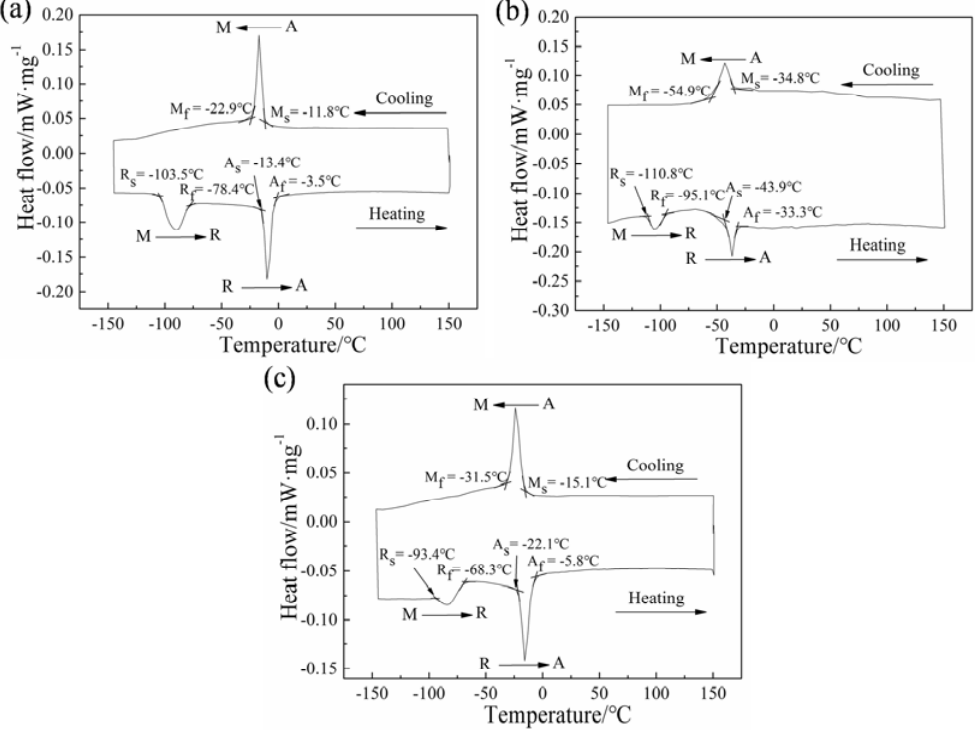
Figure 7. DSC (Differential scanning calorimetry) curves of the three NiTi-based SMAs: ( a ) Ni 45 Ti 51.8 Fe 3.2 ; ( b ) Ni 44 Ti 51.8 Fe 3.2 Nb 1 ; ( c ) Ni 44 Ti 51.8 Fe 3.2 Ta 1 . Compared to Ni 45 Ti 51.8 Fe 3.2 SMA, Ni 44 Ti 51.8 Fe 3.2 Nb 1 and Ni 44 Ti 51.8 Fe 3.2 Ta 1 SMAs possess a lower